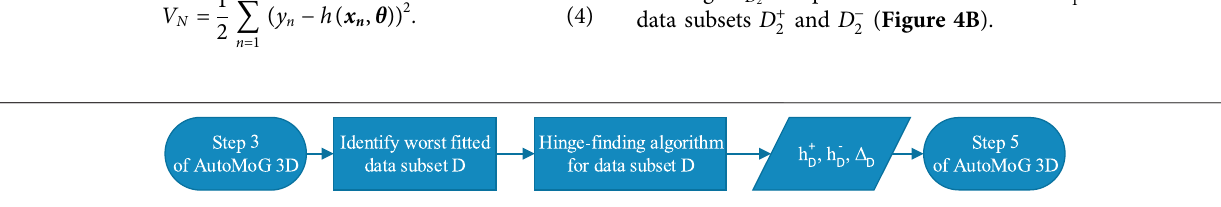
FIGURE 3 | Flowchart of step 4 in AutoMoG3D. The worst fi tted data subset D is partitioned into two new data subsets D + and D − by the hinge- fi nding algorithm. The data subsets D + and D − are approximated by the hyperplanes h + D and h − D , respectively. The hyperplanes h + D and h − D are separated at the hinge Δ D .